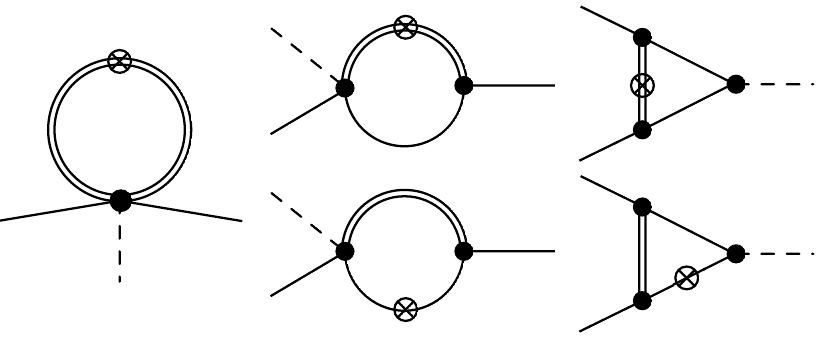
Figure 2 . Further diagrams contributing to the running of the Yukawa coupling (denoted as D y y ). In the unimodular gravity framework only the triangle diagrams in the last column are non-zero. In the Weyl-squared gravity case the only non-vanishing diagram is the tadpole in the (cid:12)rst column. Within the standard asymptotically safe quantum gravity (ASQG) framework all the diagrams depicted above may lead to non-trivial contributions (depending on the gauge